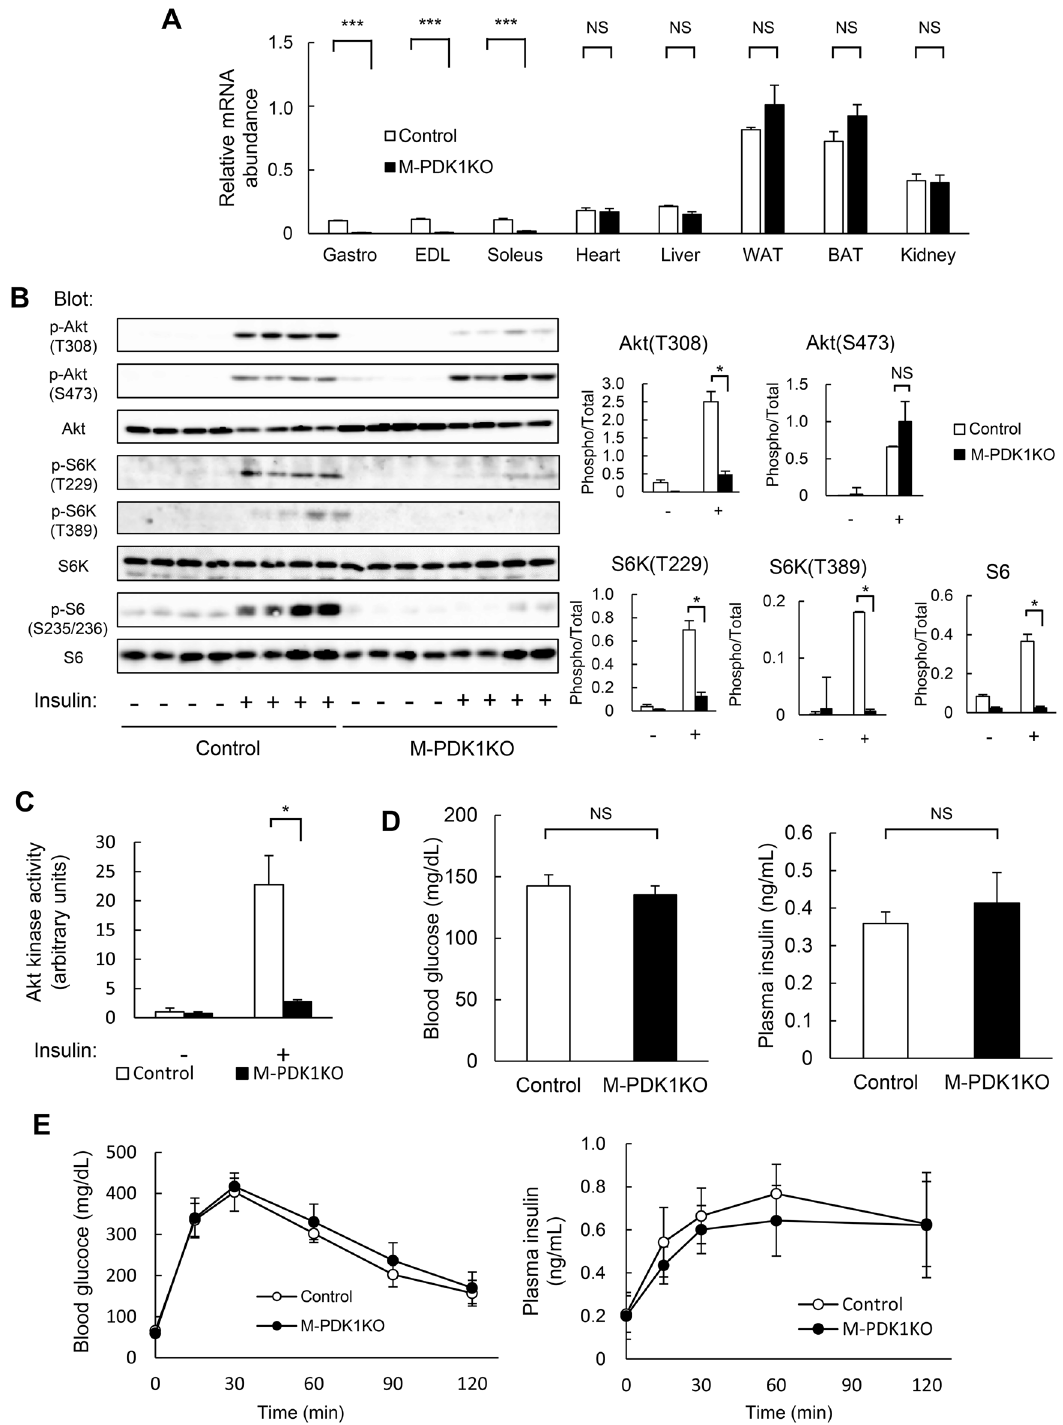
Figure 1. Insulin signaling in skeletal muscle as well as glucose tolerance in M-PDK1KO mice. ( A ) Quantitative RT-PCR analysis of PDK1 mRNA in various tissues of control and M-PDK1KO mice ( n = 4 each) at 12 weeks of age. Gastro, gastrocnemius; EDL, extensor digitorum longus; WAT and BAT, white and brown adipose tissue, respectively. ( B , C ) Immunoblot analysis of insulin signaling molecules ( B ) as well as assay of Akt kinase activity ( C ) in gastrocnemius muscle at 10 min after intraperitoneal injection of human insulin (1 mU/kg) or vehicle in control and M-PDK1KO mice ( n = 3 each) at 12 weeks of age. In ( B ), each lane of the left panel represents a sample from one mouse, and quantitative data are shown in the left panels. Each band was quantified with the use of the ImageQuant TL software. ( D , E ) Blood glucose and plasma insulin levels both in the ad libitum fed state ( D ) and during an intraperitoneal glucose tolerance test ( E ) in control and M-PDK1KO mice [ n = 9 and 7, respectively, in ( D ); n = 6 each in ( E )] at 12 weeks of age. All quantitative data are means ± SEM. * P < 0.05, *** P < 0.001; NS, not significant [Student’s t test in ( A , D , E ) and one-way ANOVA followed by Tukey’s test in ( B , C